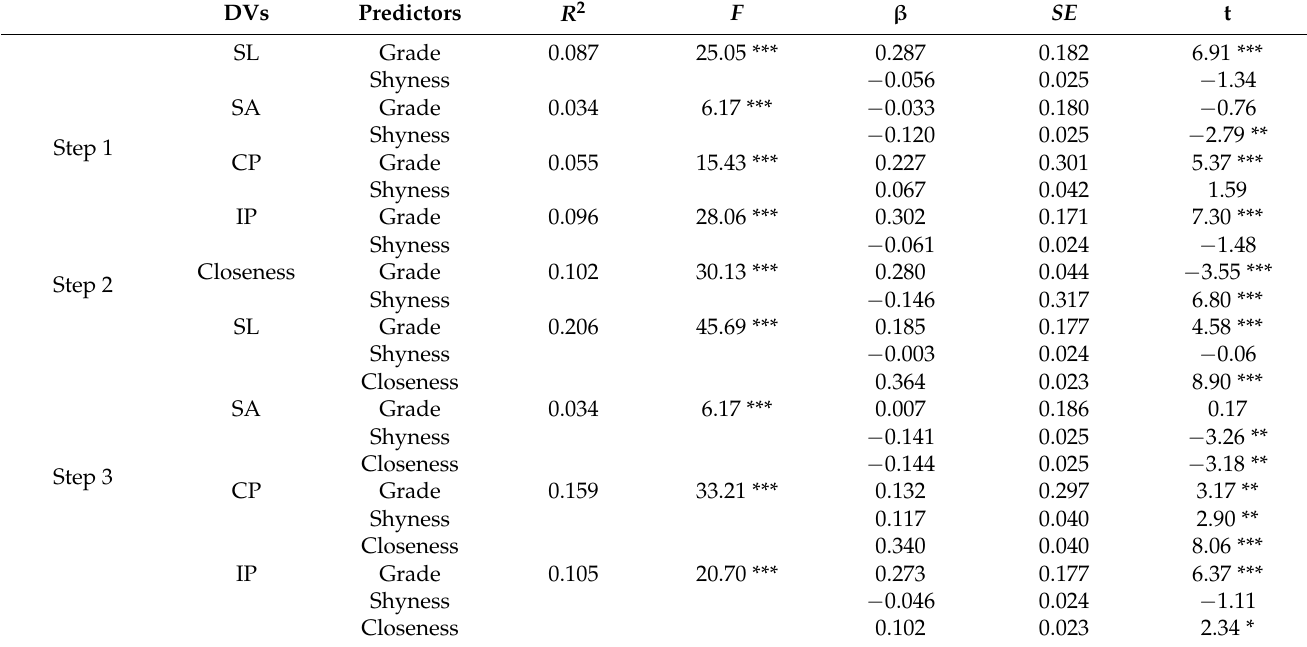
Table 4. Mediation